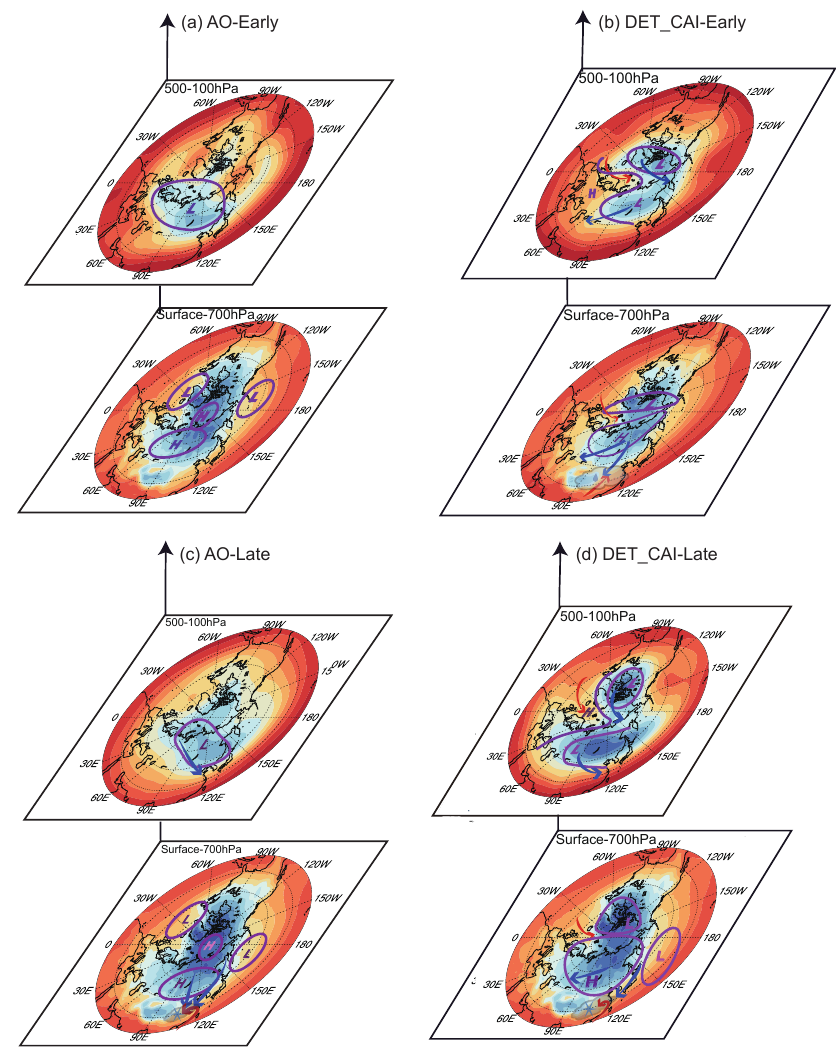
Figure 10. Conceptual model of the cold wave response to negative AO in ( a ) early and ( c ) late winter and ( b,d ) that for the response to negative DET_CAI, respective. The color shading represents the temperature, and the purple contours indicate the high and low systems. The red and blue arrows show warm and cold advections, respectively. The blue droplets indicate regions of rainfall, and the blue stars indicate regions of